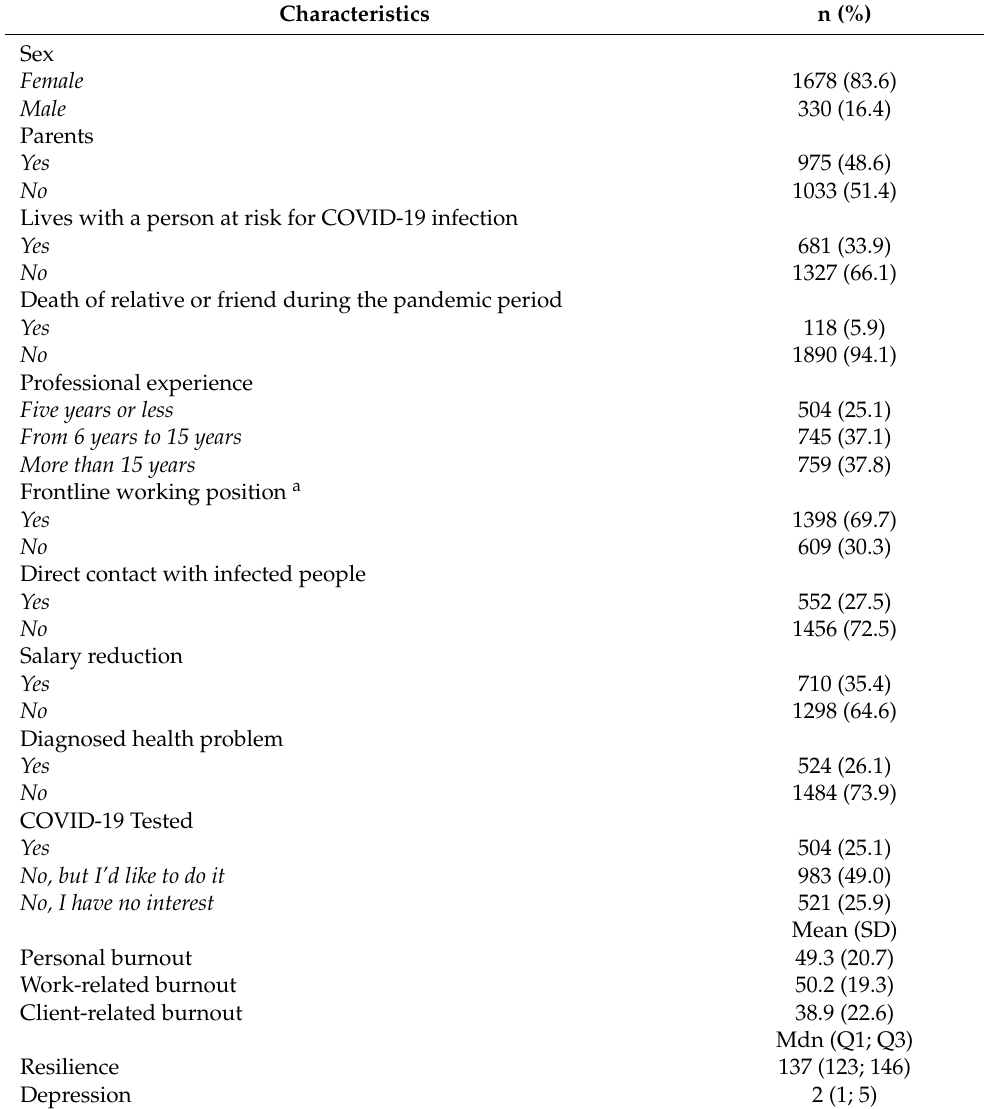
Table 1. Characteristics of participants (n =